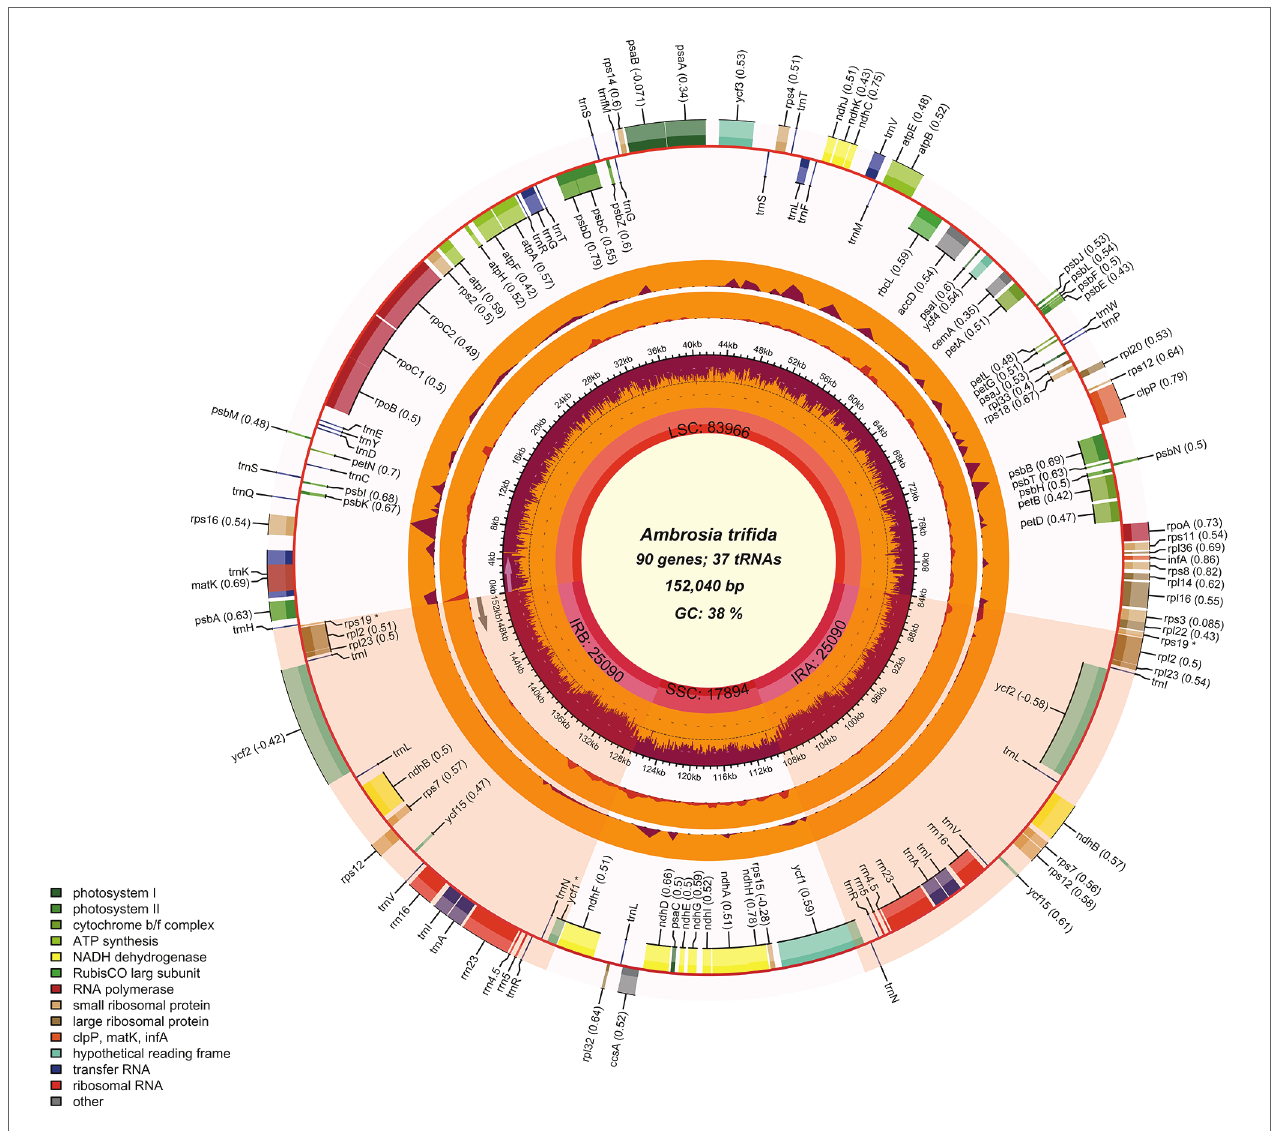
FIGURE 2 | Chloroplast genome map of giant ragweed ( Ambrosia trifida L.). The species name and specific information regarding the genome (length, GC content, and the number of genes) are depicted in the center of the plot. In the first inner circle, the optional GC content is depicted as the proportion of the shaded parts of each section. The length of the corresponding single short copy (SSC), inverted repeat (IRa and IRb), and large single-copy (LSC) regions is also given. The gradient GC content of the genome is plotted in the second circle with zero level based on the outer circle. Extending outward, the next two layers are the optional input indices of the nucleotide and indel diversity of A. trifida compared with Ambrosia artemisiifolia , respectively. The gene names and their optional codon usage bias are labeled on the outermost layer, with pseudogenes marked with asterisks. Genes are color-coded by their functional classification. Represented with arrows, the transcription directions for the inner and outer genes are listed clockwise and anticlockwise, respectively. The optional gene specific GC content is depicted with the proportion of shaded areas. The optional shaded area stretching from the inner sphere toward the outer circle marks the IR